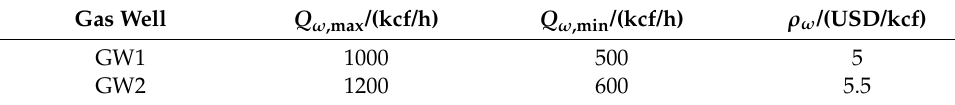
Table A4. Parameters of gas wells.